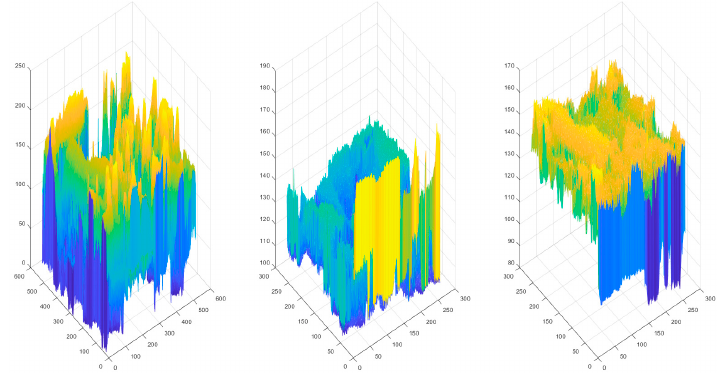
Figure 3. Equivalent distribution of pixels in YEF color space.